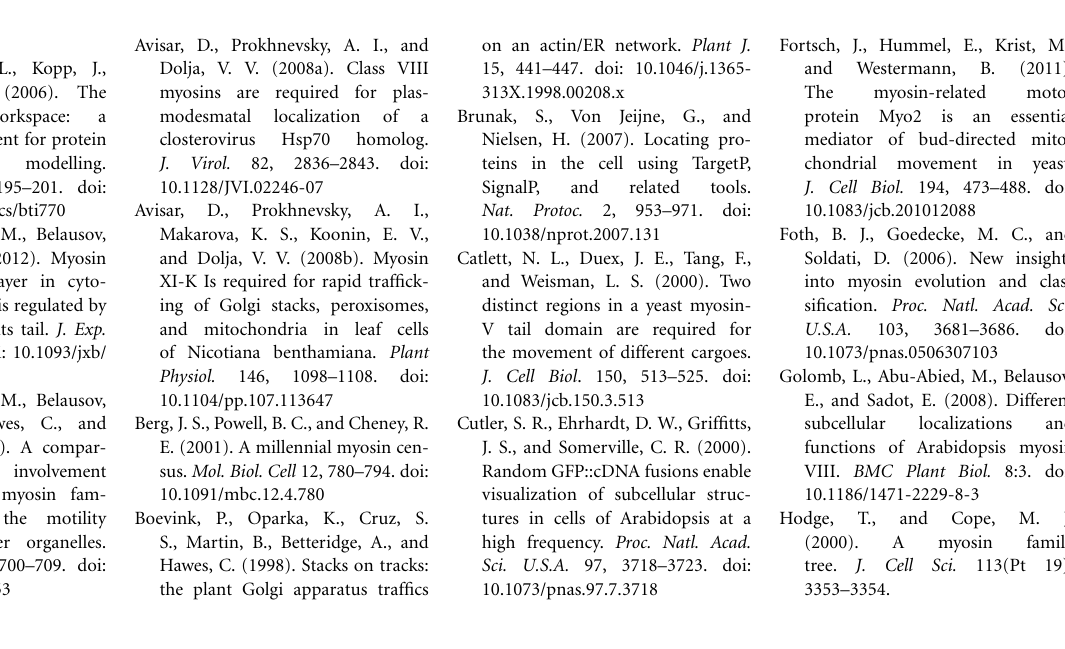
Table S2 | List of primers used in this